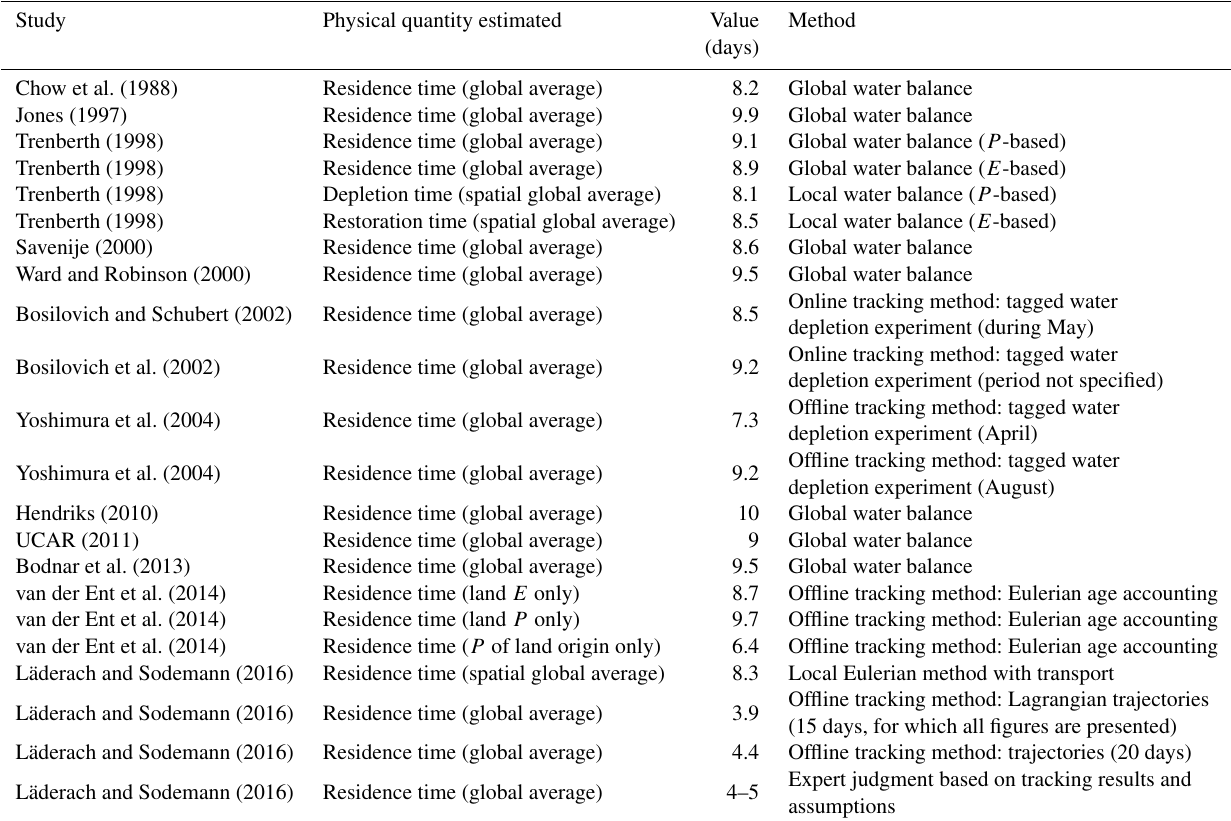
Table 1. Non-exhaustive overview of (near-)global residence time estimates for water in the atmosphere in previous studies. Note that the estimates from this study are shown in Fig.